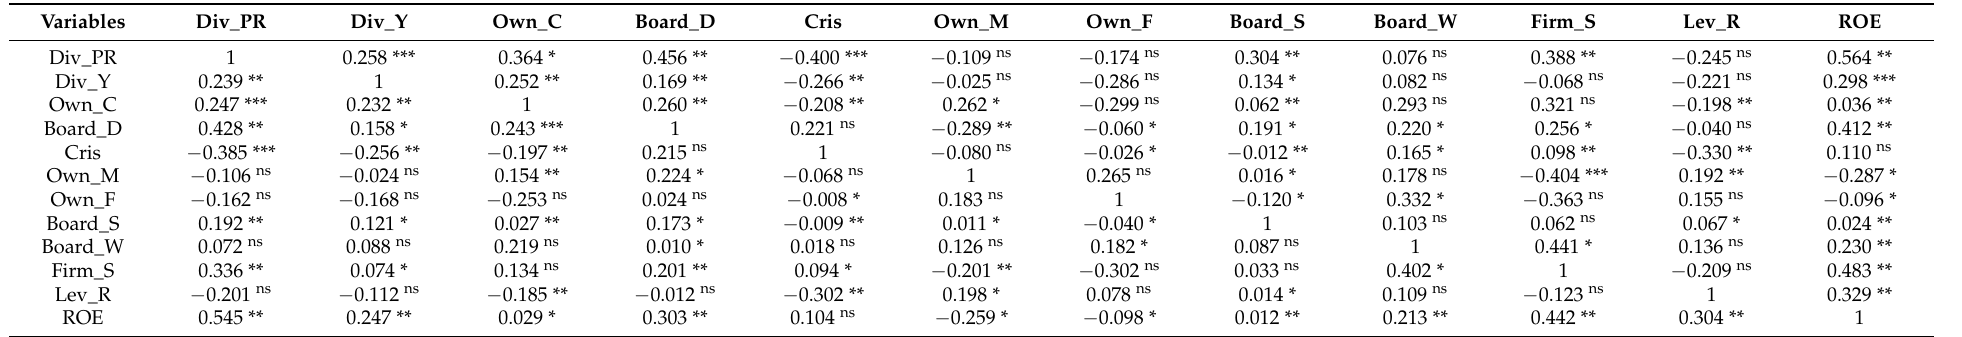
Table 3. Spearman/Pearson Correlation Matrix. The Spearman correlations are above the diagonal and Pearson rank-correlation are below the diagonal.